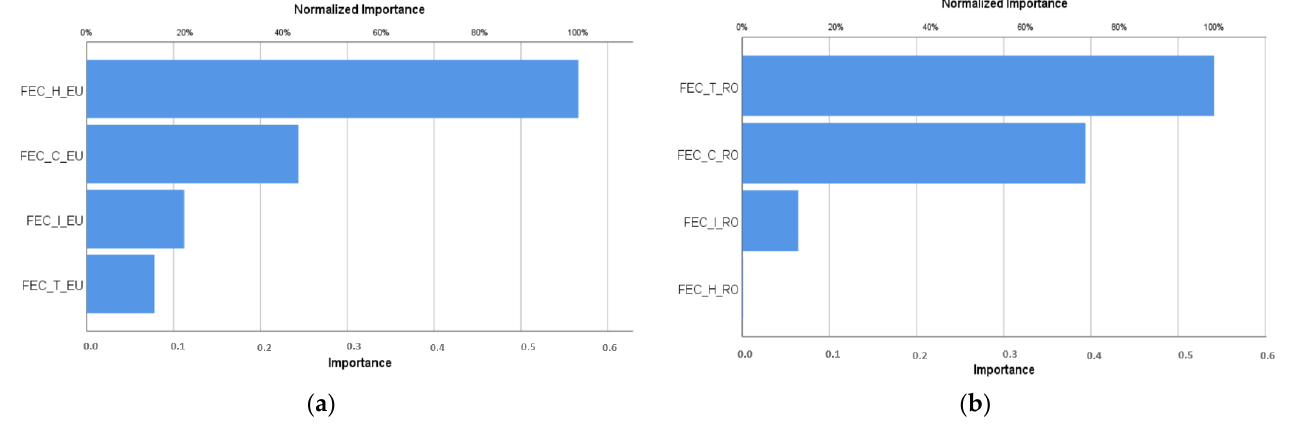
Figure 18. Normalized importance. Source: Developed by the authors on the basis of the data calculated with SPSS Statistics: ( a ) EU; ( b ) RO. Table 7. Impact of sector-specific final energy consumption on economic